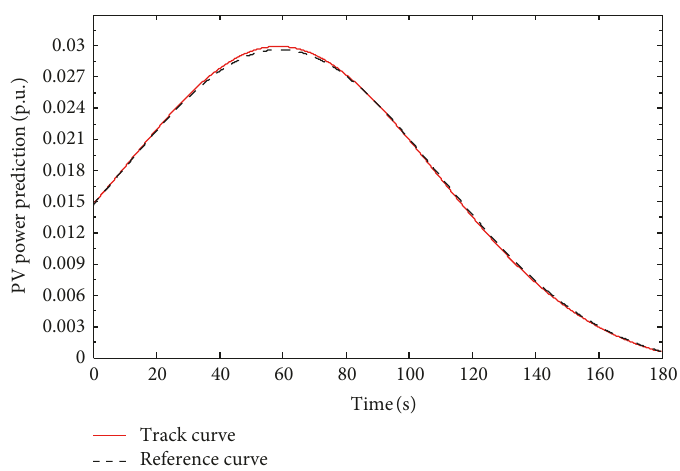
Figure 8: The predictive PV power by the neural network observer.